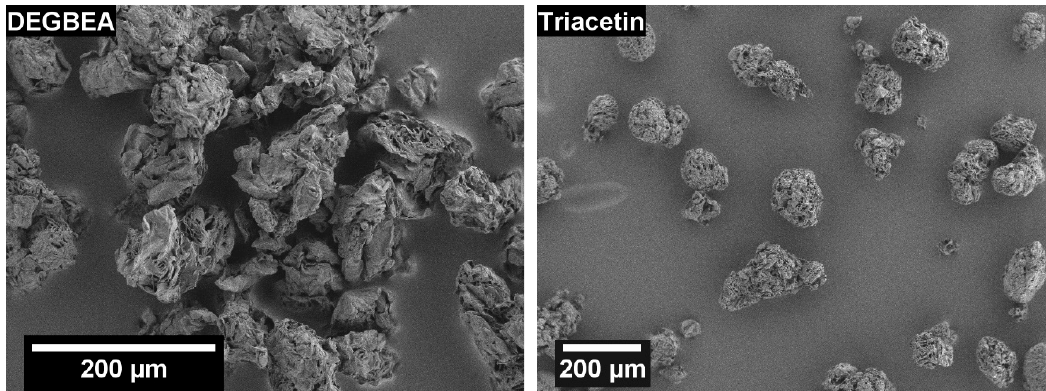
Figure 1. Scanning electron microscopy (SEM) images of precipitated Polyoxymethylene (POM) particles obtained in solvent screening experiments from acetophenone (top, left), benzaldehyde (top, right), benzyl benzoate (middle, left), benzyl ether (middle, right), diethylene glycol n-butyl ether aceta (DEGBEA) (bottom, left), and triacetin (bottom, right).